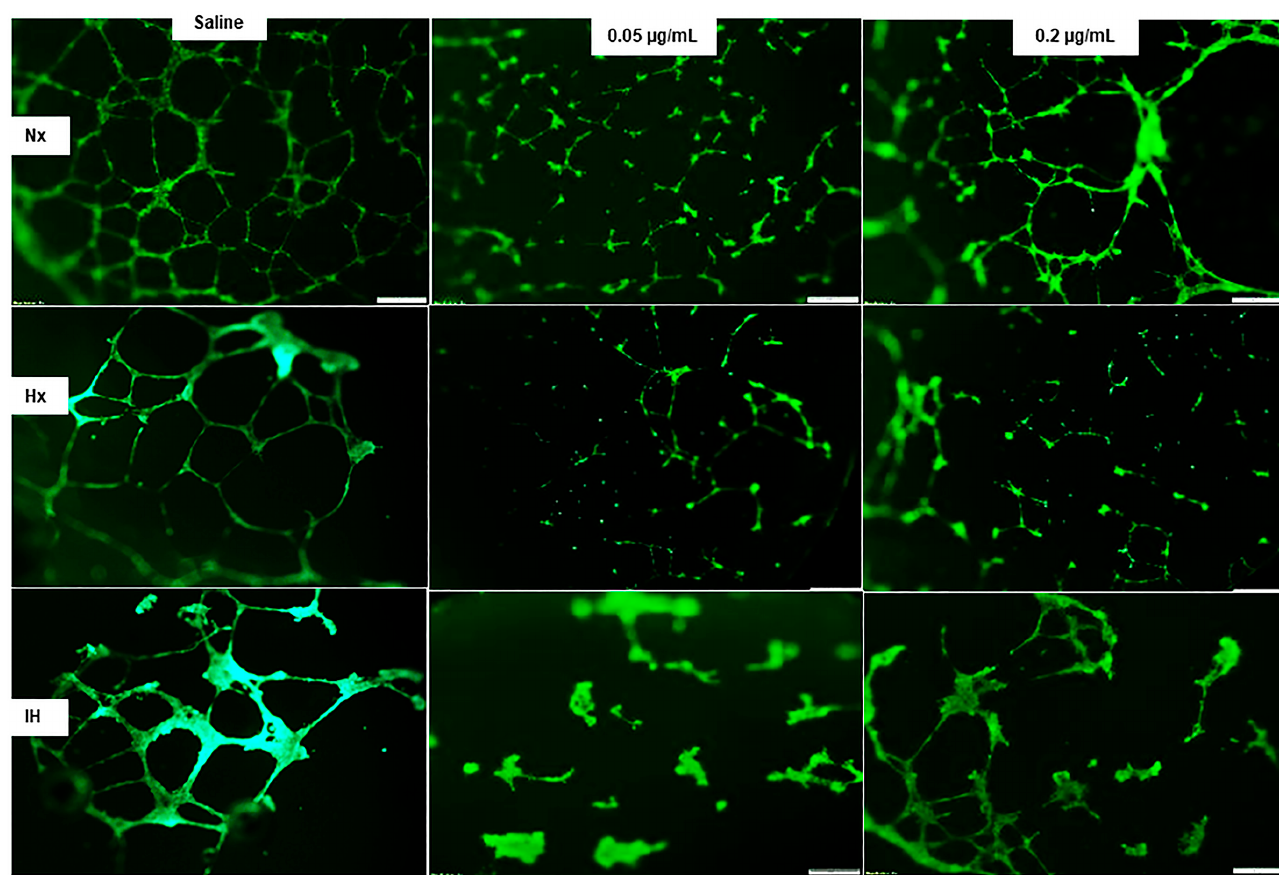
Figure 10. Dose-response effect of bumetanide on tube formation capacity of cultured human microvascular retinal endothelial cells (HMRECs) exposed to exposed to normoxia (Nx), hyperoxia (Hx, 50% O 2 ), or intermittent hypoxia (IH) for 72 h. Cells from each group were plated at 2 × 10 5 in 50 µ L media in each well. Cells were labelled with BD calcein AM Fluorescent dye (green). Images were captured at 4 × magnification (scale bar is 200 µ m). Tube formation assays were conducted in three 96-well plates, one in Nx, one in Hx, and one in IH. In each plate, 32 wells were treated with saline, 32 with low-dose bumetanide (0.05 µg/mL), and 32 with high-dose bumetanide (0.2 µg/mL). Quantitative analysis for the number of tubes formed in each group is presented in Table 1.